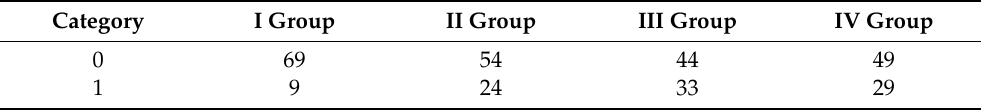
Table 10. Number of observations by category of the dependent variable and group based on quartiles of revenue volumes in